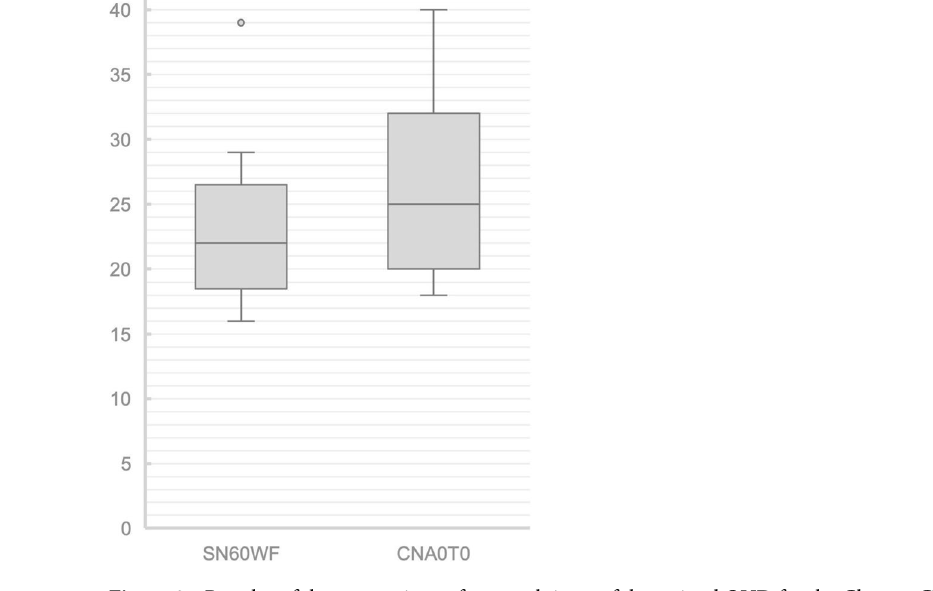
Figure 3. Boxplot of the comparison of removal times of the stained OVD for the Clareon CNA0T0 (n = 9) and AcrySof SN60WF (n = 9) IOLs; there was no significant difference ( P = 0.27,